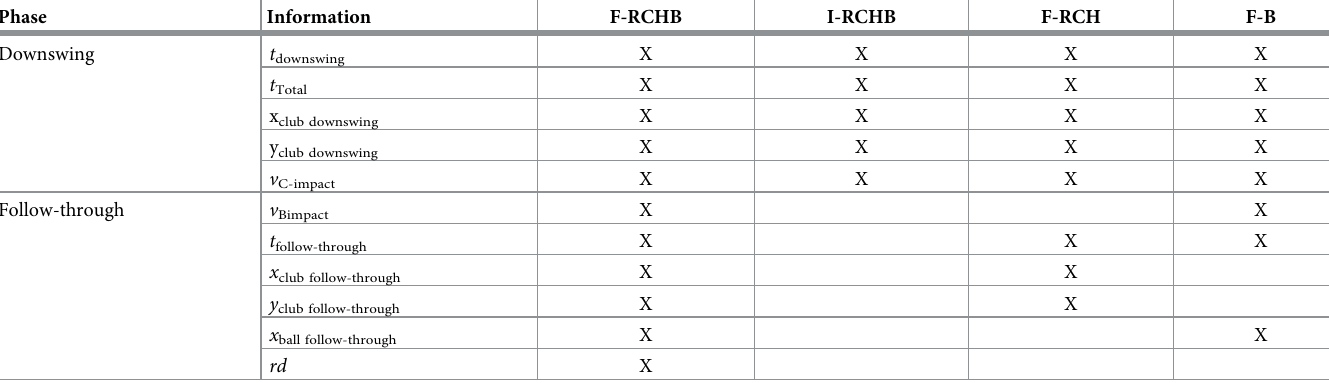
Table 14. Comparison of available spatio-temporal information in F-RCHB, I-RCHB, F-RCH, and F-B. Explanations: see text.